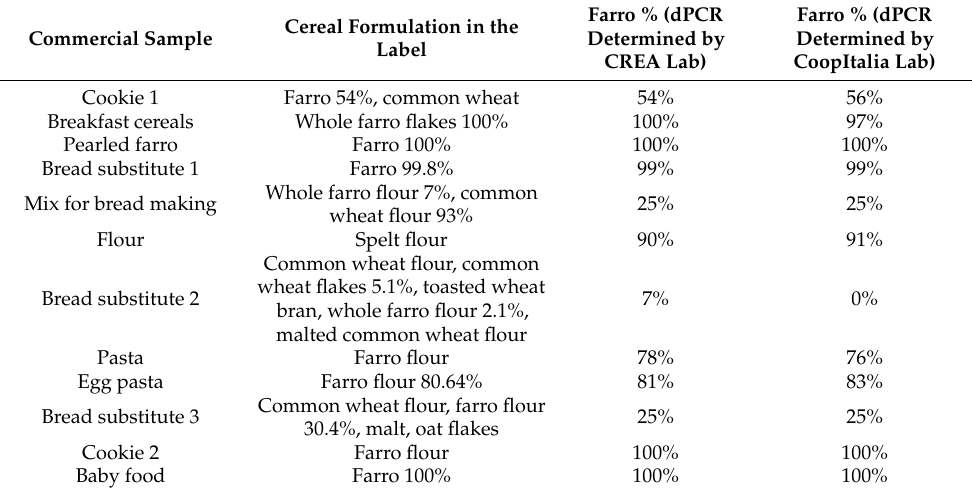
Table 5. Commercially available food sampled, their cereal content as reported in the label and hulled wheat percentages determined by the two CREA and CoopItalia laboratories using dPCR